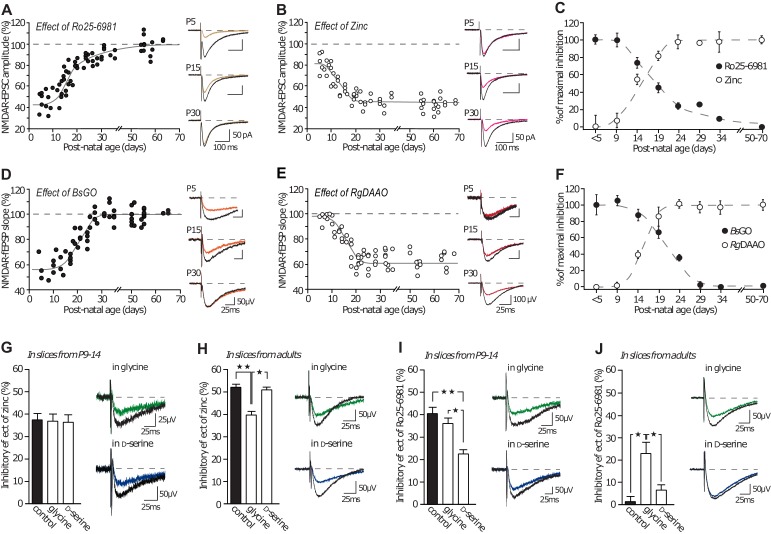
GluN2A/GluN2B developmental ratio is differently changed by the co-agonists availability.(A–B) Inhibition mediated by Ro25-6981 (A) and by Zinc (B) on NMDAR-EPSCs in P5 to P70 rats slices. Each dot represents a single experiment. (C) Summary of Ro25-6981 and zinc inhibitory effects throughout development. Data are normalized to the maximal and minimal inhibitory effects and displayed for animals younger than P5 (<P5), from P5-P9 (P9), etc. (D–E) Effects of BsGO (d) and RgDAAO (e) on NMDAR-fEPSPs in P5 to P70 rat slices. (F) Summary of BsGO and RgDAAO inhibitory effects throughout development. Each dot represents a single experiment. n and p values can be found in Supplementary file 1. (G–H) Inhibitory effects of zinc on NMDAR-fEPSPs in P10-15 rat slices (G) and in adult rat slices (H). P9-P14 slices: n = 7, p=0.9319, adults slices: n = 6, p=0.0032; Kruskal-Wallis test, followed by Dunn's multiple comparison test *p<0.05, **p<0.01. (I–J) Inhibitory effects of Ro25-6981 on NMDAR-fEPSPs in P10-15 rat slices (I) and in adult rat slices (J). P9-P14 slices: n = 6 control and D-serine, n = 7 glycine, p=0.0004, adults slices: n = 13 control, n = 12 glycine, n = 11 D-serine; p=0.0003; Kruskal-Wallis test followed by Bonferroni's multiple comparison test *p<0.05, **p<0.01. Data are present as mean ± s.e.m.